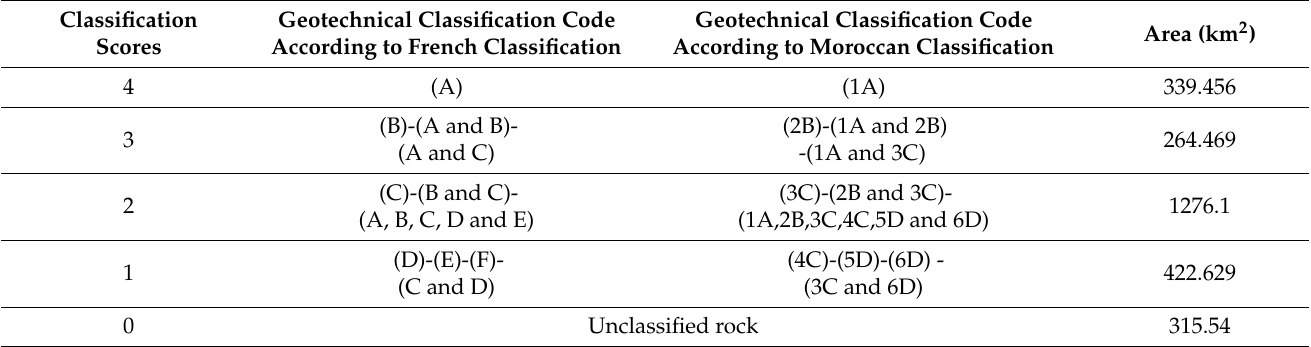
Table 6. The assigned area by classification for each rock outcrop in the study